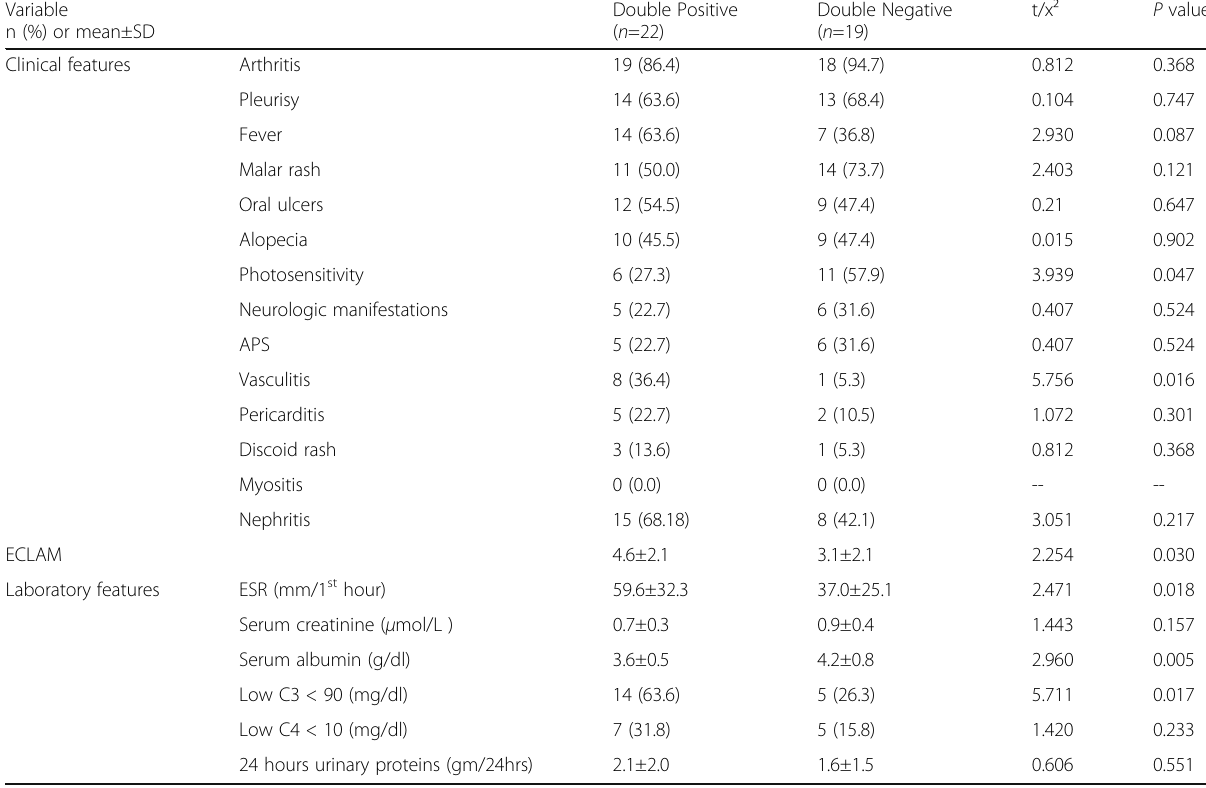
Table 6 Relationship between double positivity of anti-nuclesome and anti-C1q antibodies and other disease parameters among patients under study Variable n (%) or mean±SD